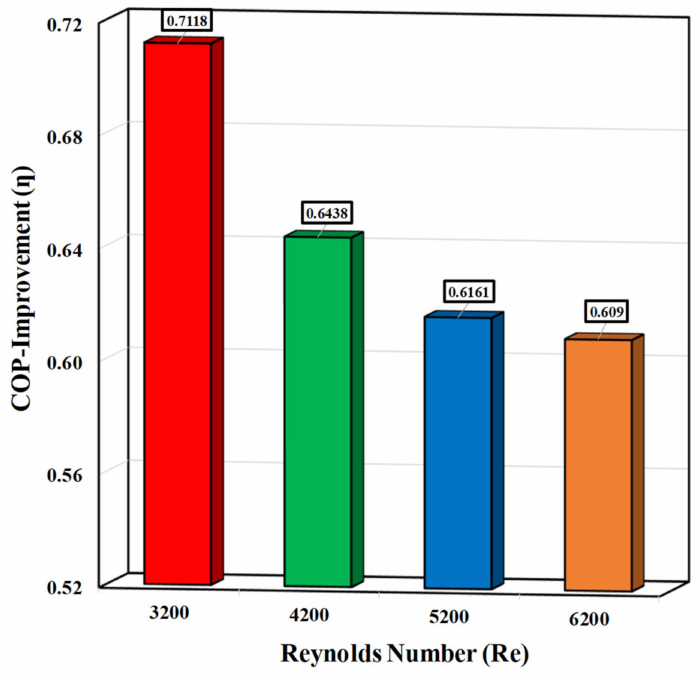
Figure 20. COP improvement when using Ag-MgO/water hybrid nanofluid with different Reynolds numbers at φ = 0.10.